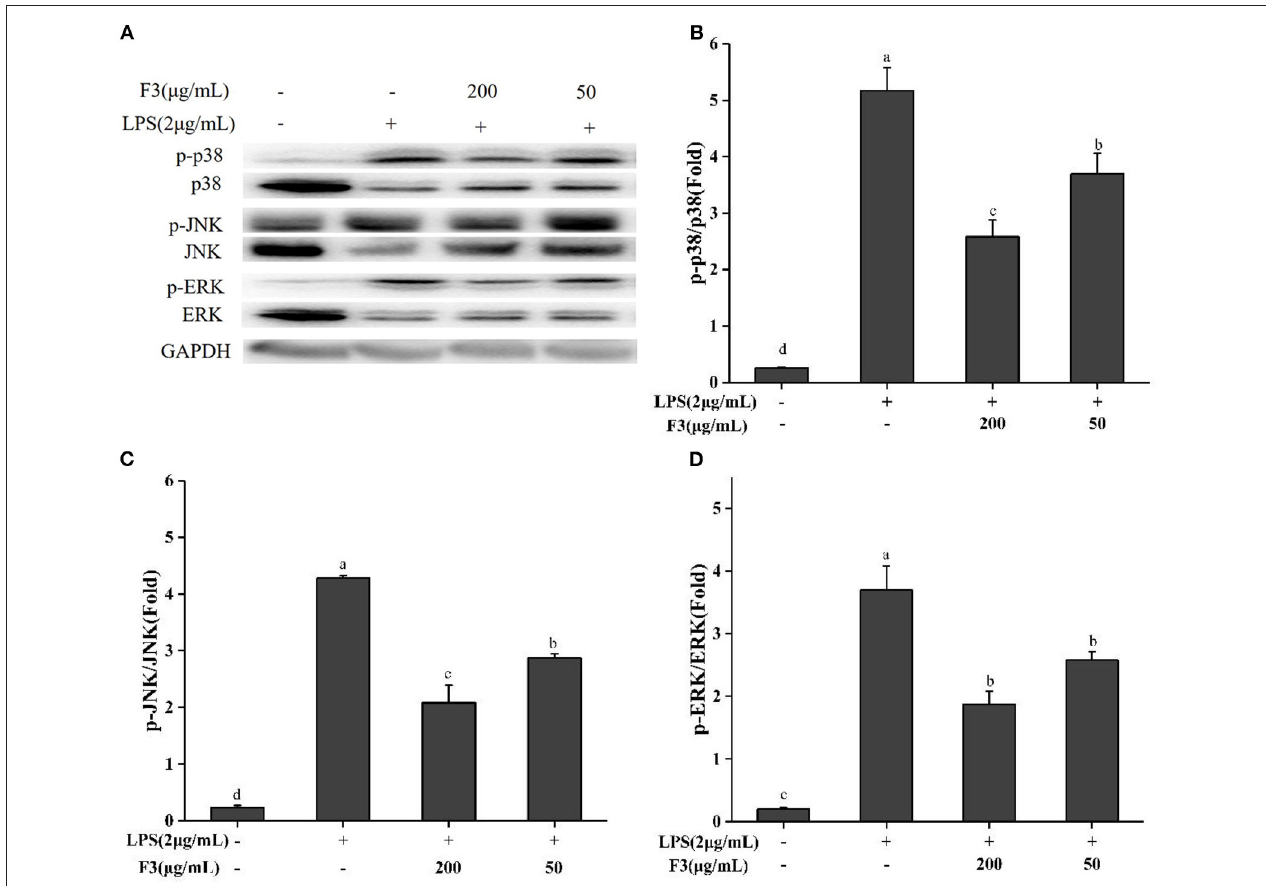
FIGURE 6 | Effects of F3 on the MAPKs proteins in RAW264.7 cells. The levels of p-p38, p38, p-JNK, JNK, p-ERK, and ERK (A) . Fold of p-p38/p38 (B) , p-JNK/JNK (C) , and p-ERK/ERK (D) . The results were expressed as means ± SD ( n = 3), where lowercase letters indicate significantly different at p < 0.05.